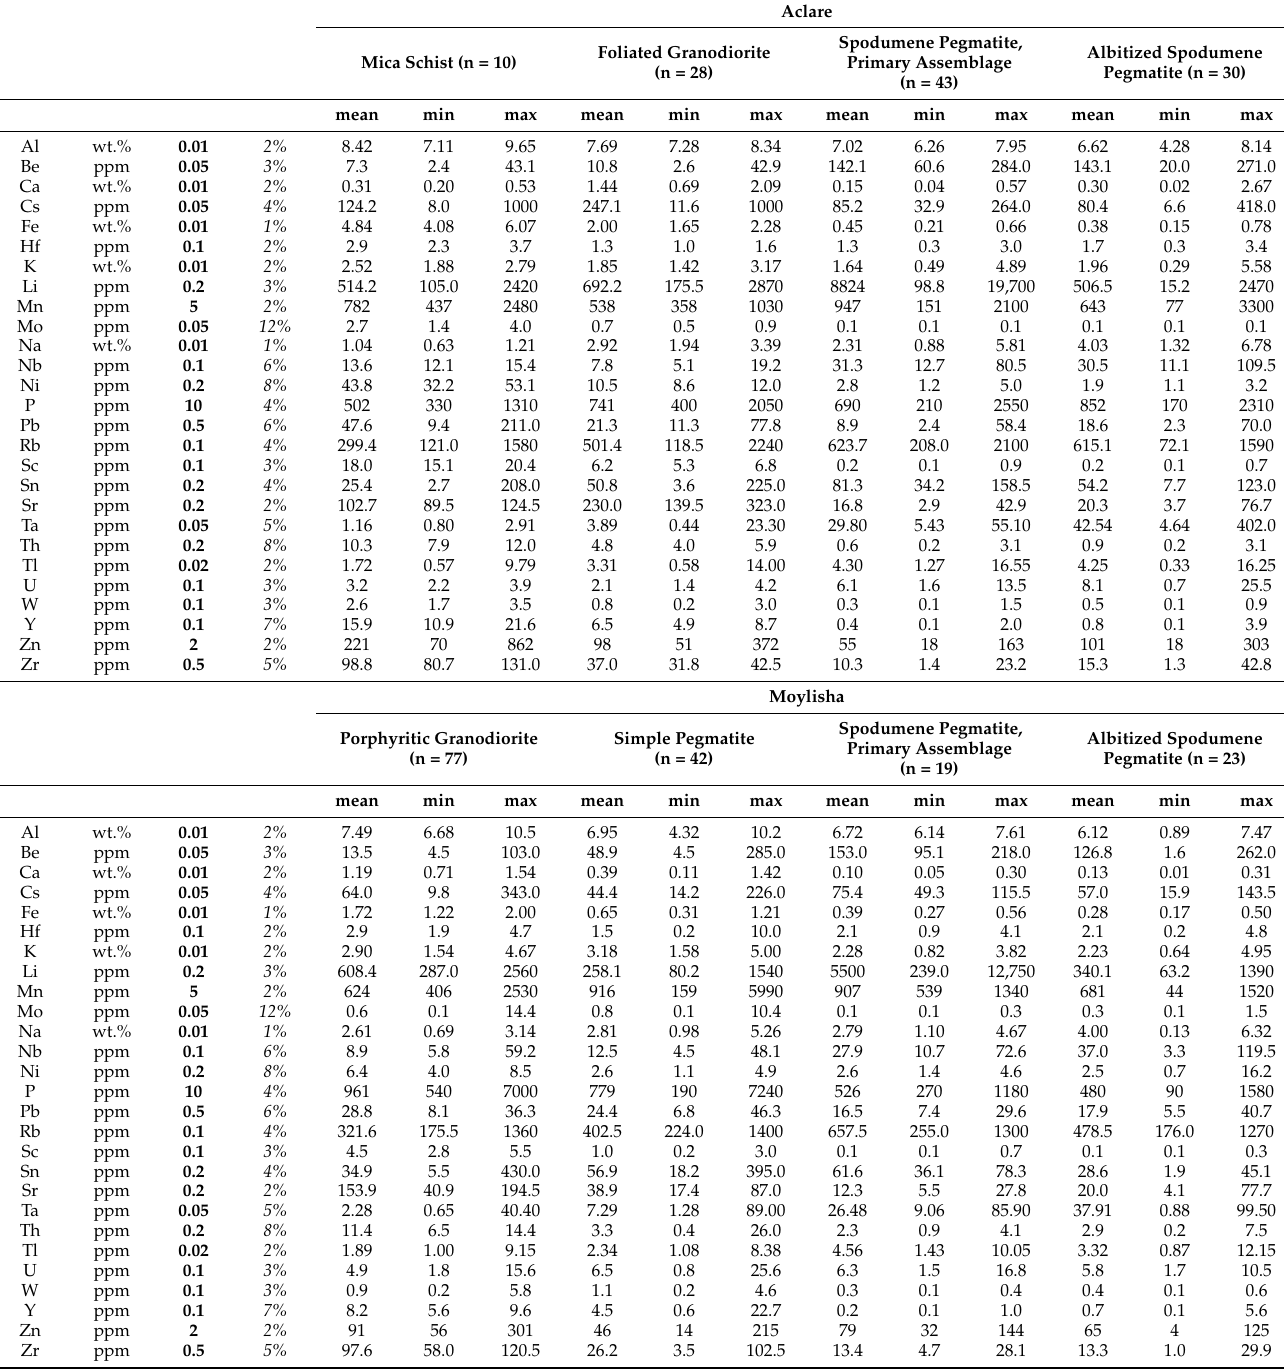
Table 1. Summary of whole-rock analyses of pegmatites and country